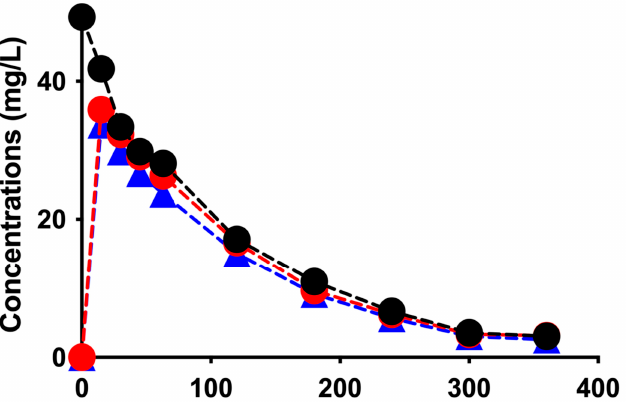
Figure 2. Time courses of vancomycin concentrations in the CC (black filled circles with dotted black line), inlet (red filled circles with dotted red line), outlet (blue filled triangles with dotted blue line), and instantaneous effluent ports (green filled circles with dotted green line) in the two sessions in the CD